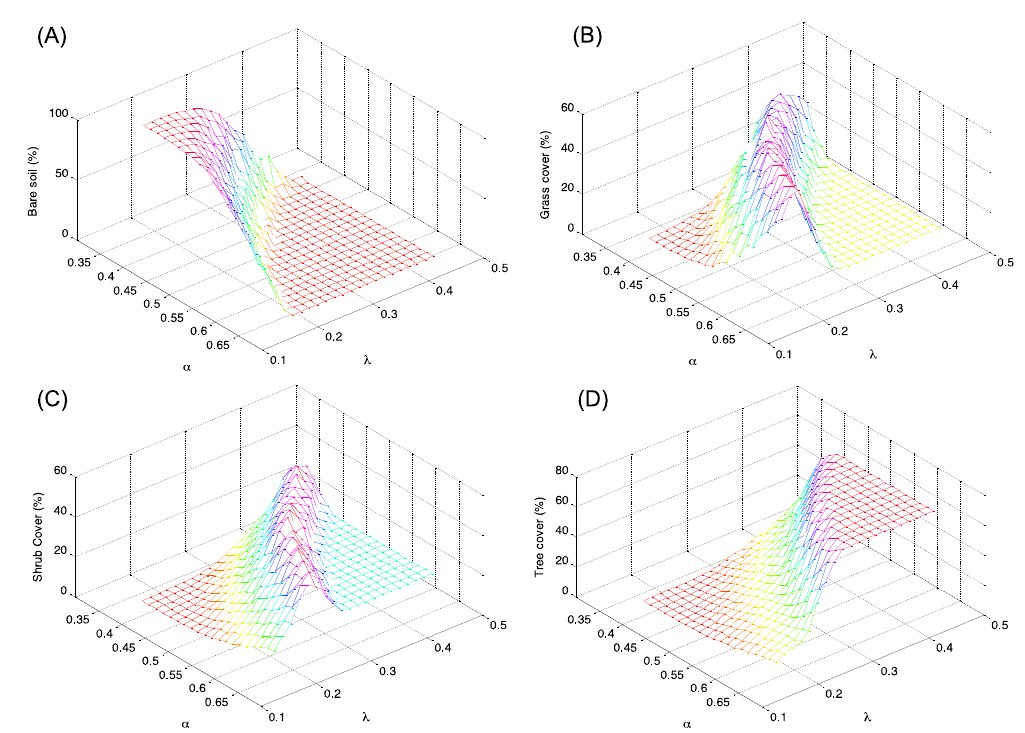
Figure 4. Distribution in percentage of the types of soil cover as a function of the climatic conditions described by rainfall parameters α and λ . Percent cover of ( A ) bare soil; ( B ) grass; ( C ) shrub; and ( D ) tree.